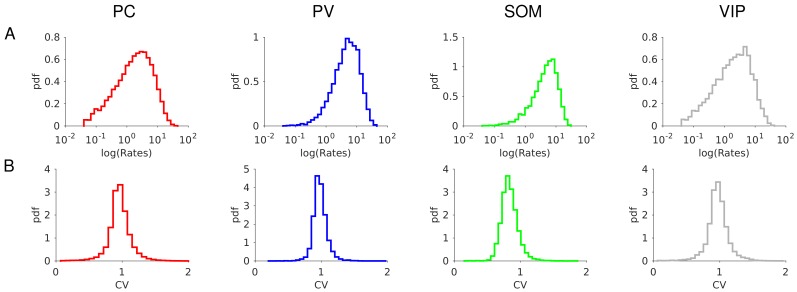
Model 1 with JEE>JEE*.Firing statistics at baseline. (A) Distribution of the firing rates (mean: rE = 3.3 Hz, rI = 6.5 Hz, rS = 5.9 Hz, rV = 3.5 Hz). (B) Distribution of CV. Color code as in Figure 5. Parameters as in Figure 5. Individual rates are averaged over 100s with a threshold at 0.05 Hz. CVs are computed over 30s.